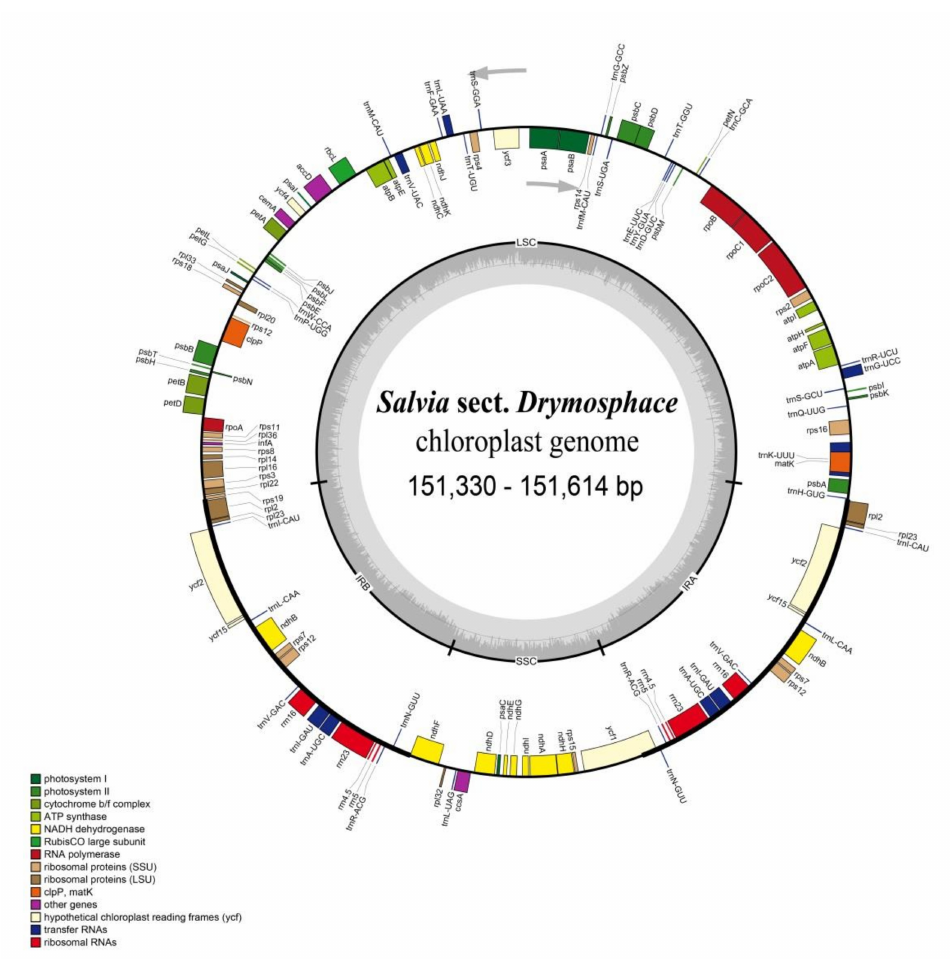
Figure 1. Complete plastome gene map of Salvia sect. Drymosphace . Genes outside of the circle are transcribed in the counterclockwise direction, and those that are inside are transcribed in the clockwise direction. LSC—large single copy; SSC—small single copy; IR—inverted repeat. A total of 114 unique genes, including 80 protein-coding, 30 tRNA, and four rRNA genes, were detected in each species (Table 3). Four rRNA, seven tRNA, and seven protein- coding genes were duplicated in IR regions (Table 3). Of the 18 genes containing intron, 15 comprised only one intron, and three genes harbored two introns. The rps12 gene was recognized as being a trans-spliced gene, with the 5 (cid:48) end located in the LSC region and the duplicated 3 (cid:48) end in the IR region (Figure 1, Table